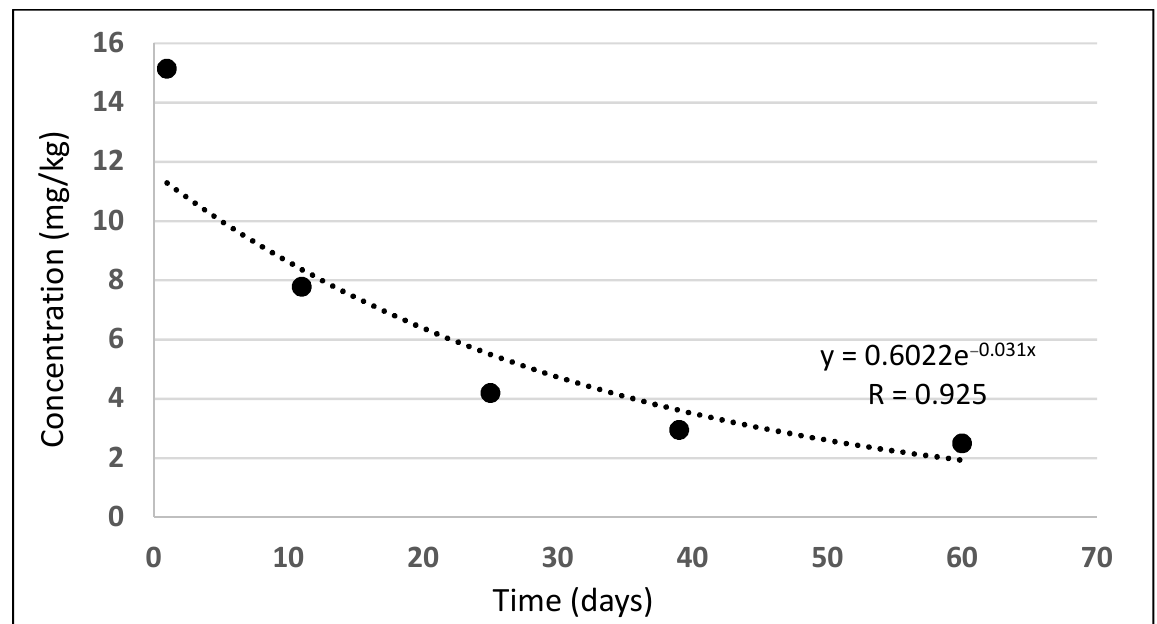
Figure 4. Flurochloridone dissipation in the soil.